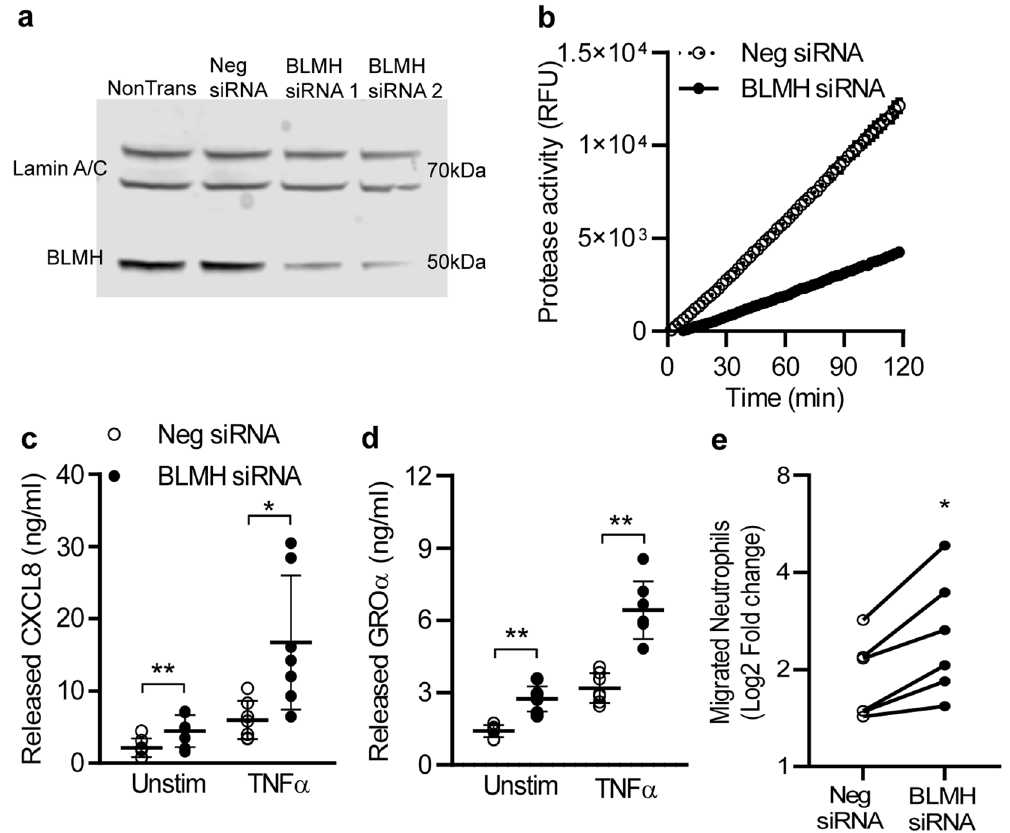
Figure 2. High levels of CXCL8 and GRO α is released from BLMH low expressing keratinocytes, with subsequent increased chemotaxis by neutrophils. ( a ) Representative image showing transfection of HaCaT cells with BLMH specific or scrambled negative siRNAs for 24 hours and Western blots analysis of the protease expression (n = 8). Full-length blots are presented in Supplementary Fig. 3a. ( b ) In paired experiments, the protease activity in cell lysates from BLMH knock-down cells and negative control were measured for 2 hours using citrulline-AMC substrate (n = 7). ( c,d ) Supernatants were collected from cells after 24 hours stimulation with or without TNF α and the levels of CXCL8 and GRO α were analysed with separate ELISAs (n = 7, one-way